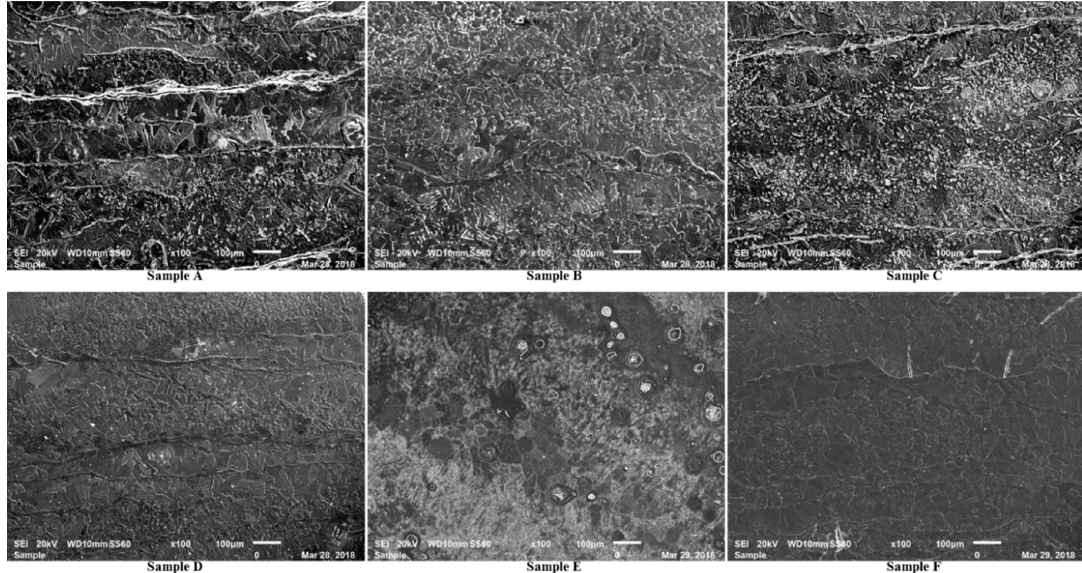
Figure 6. Microstructures of the Ti–Al as-built samples.